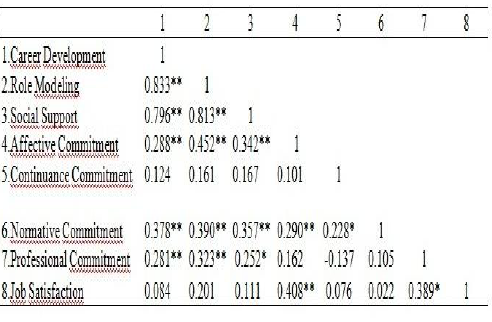
**Correlation is significant at the 0.01 level (2- tailed), *Correlation is significant at the 0.05 level (2-